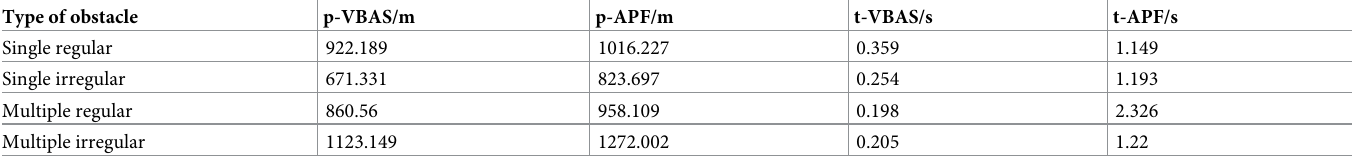
Table 2. Comparing the path planning of the VBAS algorithm and APF under different types of